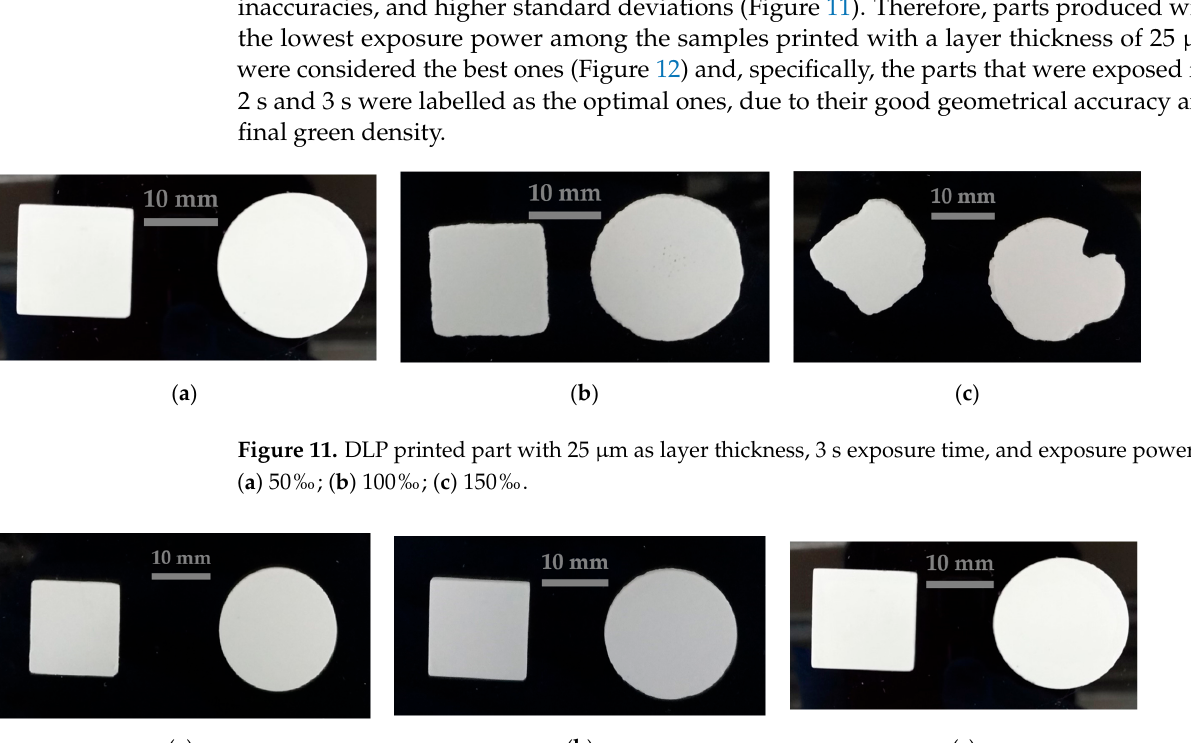
Figure 10. Side dimension ( a ) and measured density ( b ) of the DLPed plates with 25 µm layer thickness.